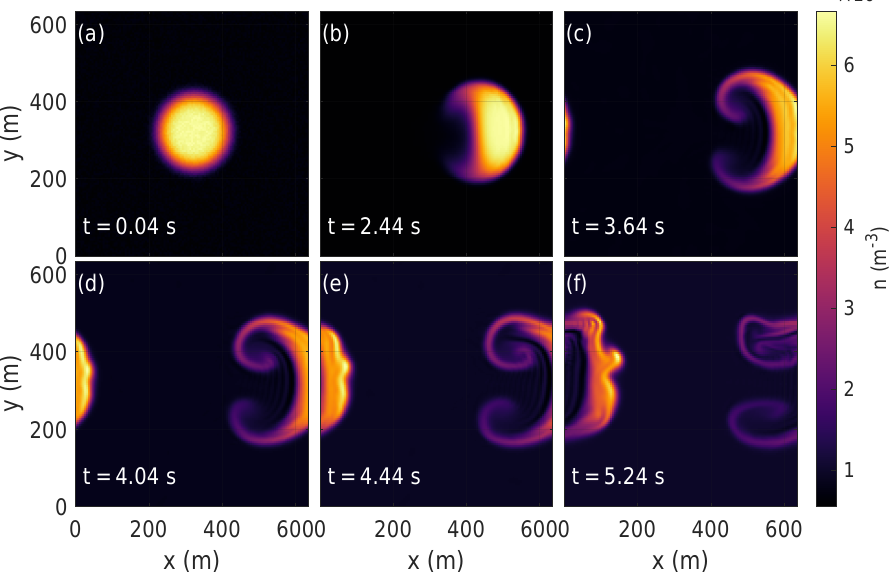
Figure 8. Density color plots of 2D slices at the mid-plane of ˆ z showing the evolution of a 3D plasma enhancement cloud simulation in an inertial regime. Panel ( a ) shows the initial cloud. Panel ( b ) shows the cloud then begins to move to the right. A finger-like structure extends from the center of the cloud, as seen in Panel ( c , d ). In Panel ( e , f ), a GDI-induced bifurcation begins to form as the tips of the finger-like structure curl itself into a secondary KHI indicated by the “mushroom heads”. In the inertial regime, the plasma cloud structure is dominated by the development of the